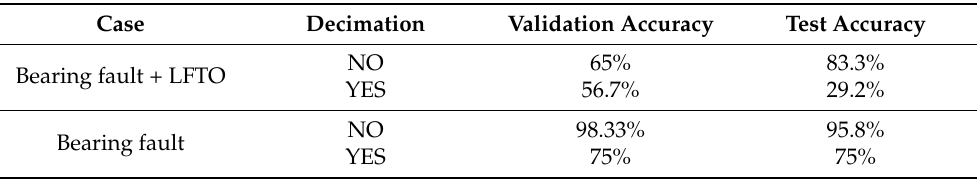
Table 5. Validation and test accuracy for the bearing fault and LFTO condition compared with the single fault condition